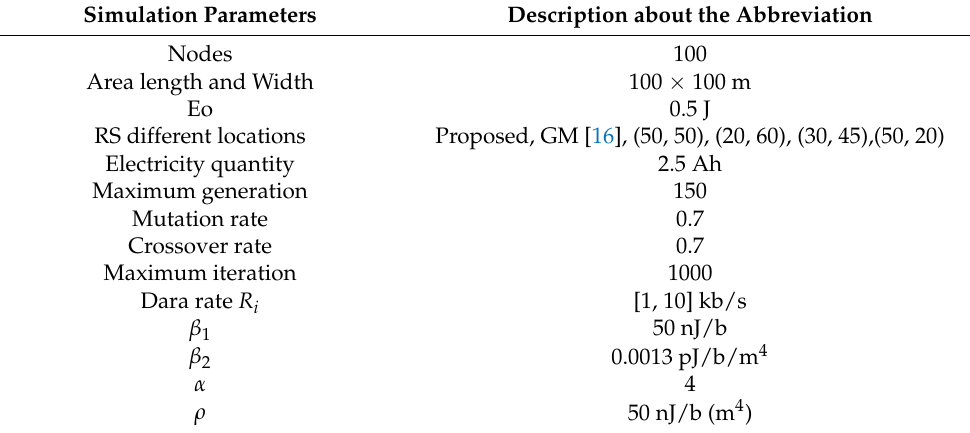
Table 2. Parameters